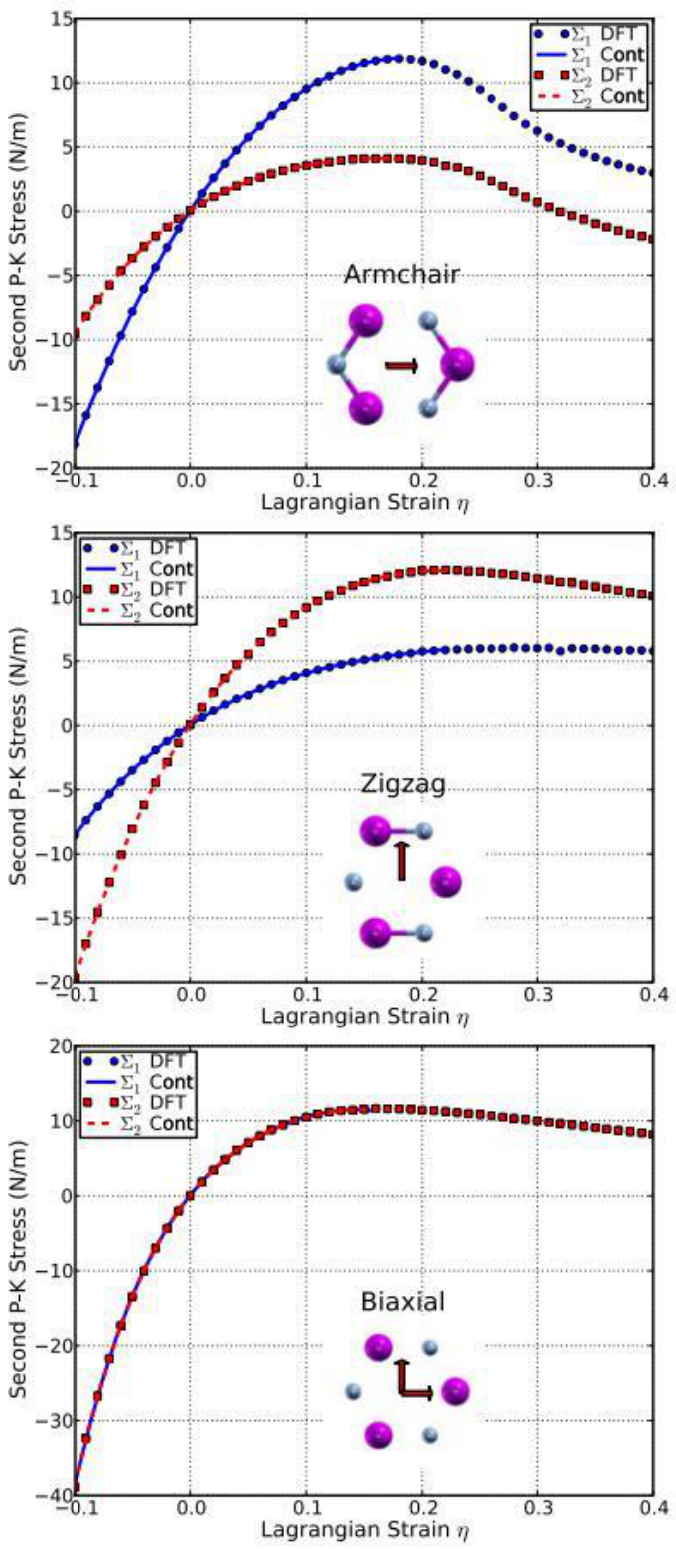
Figure 15. Stress–strain responses of g -GaN under the armchair, zigzag, and biaxial strain. Σ 1 ( Σ 2 ) denotes the x ( y ) component of stress. “Cont” stands for the fitting of DFT calculations (“DFT”) to continuum elastic